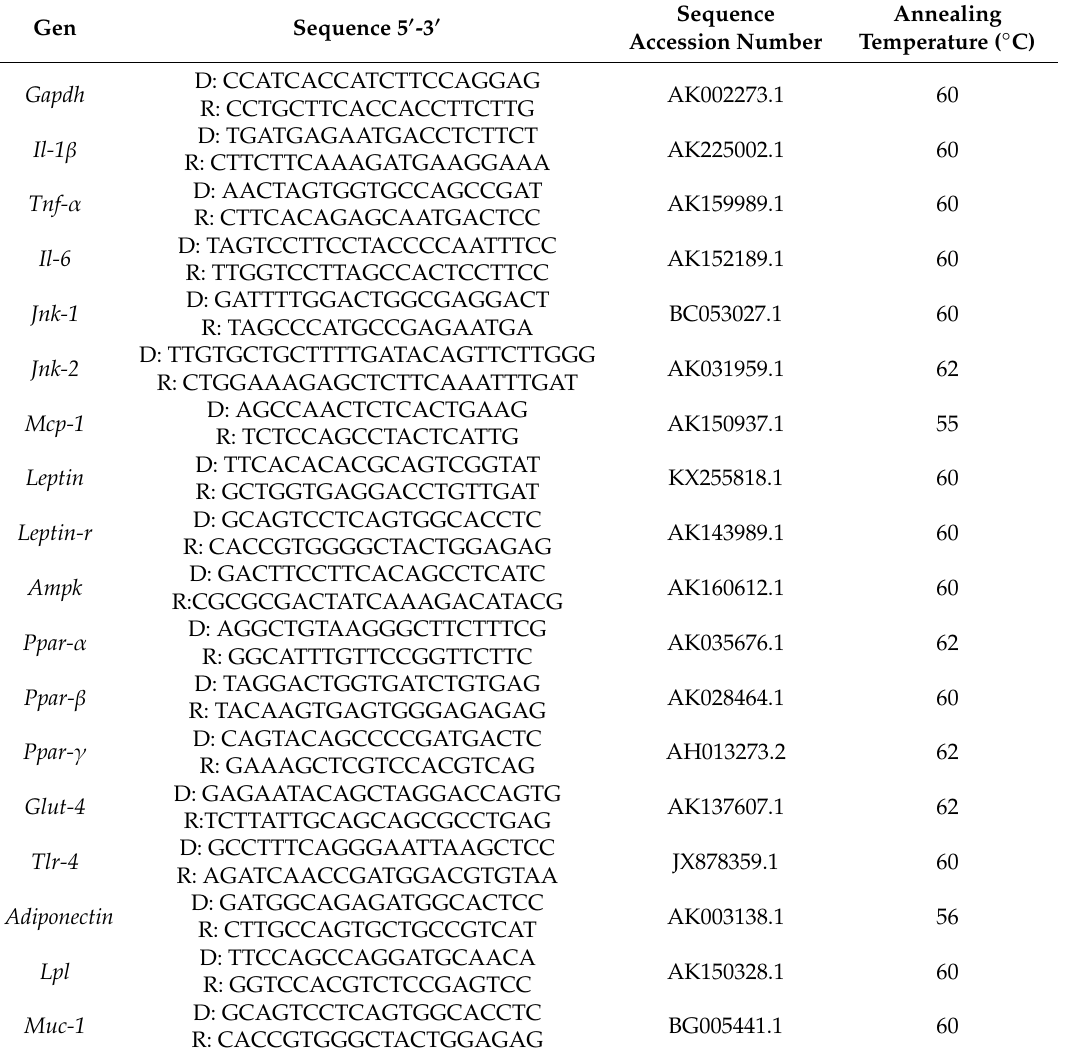
Table 1. Primer sequences used in real-time PCR